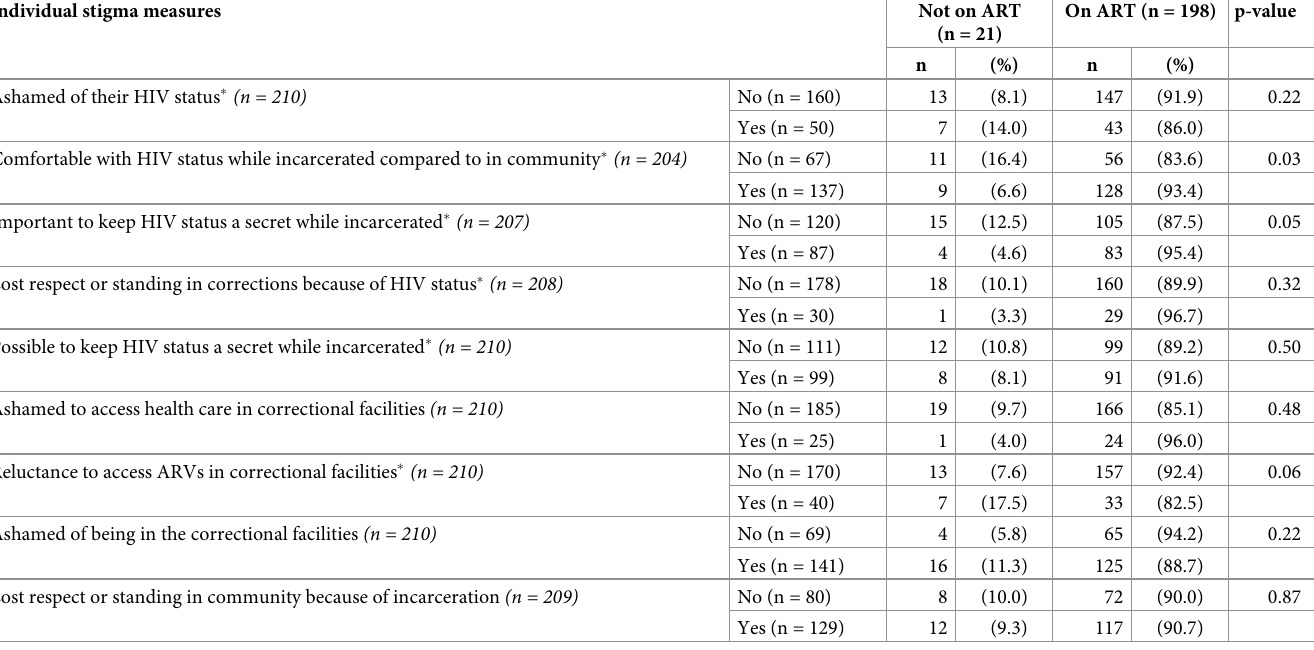
Table 2. Reported experiences of stigma from TasP study participants by ART status at selected correctional facilities in Gauteng and Western Cape Provinces, South Africa (2016–2018). Individual stigma measures